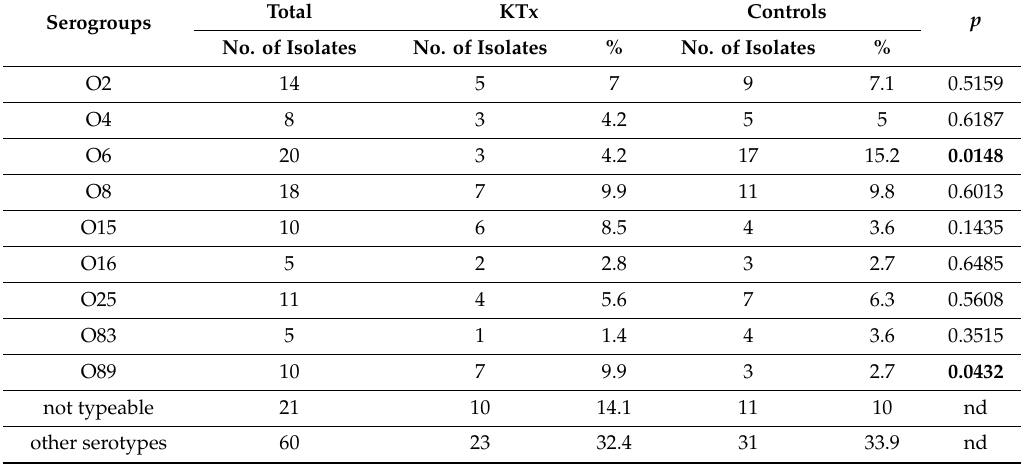
Table 3. Distribution of O serotypes in relation to KTx and control UPEC isolates.